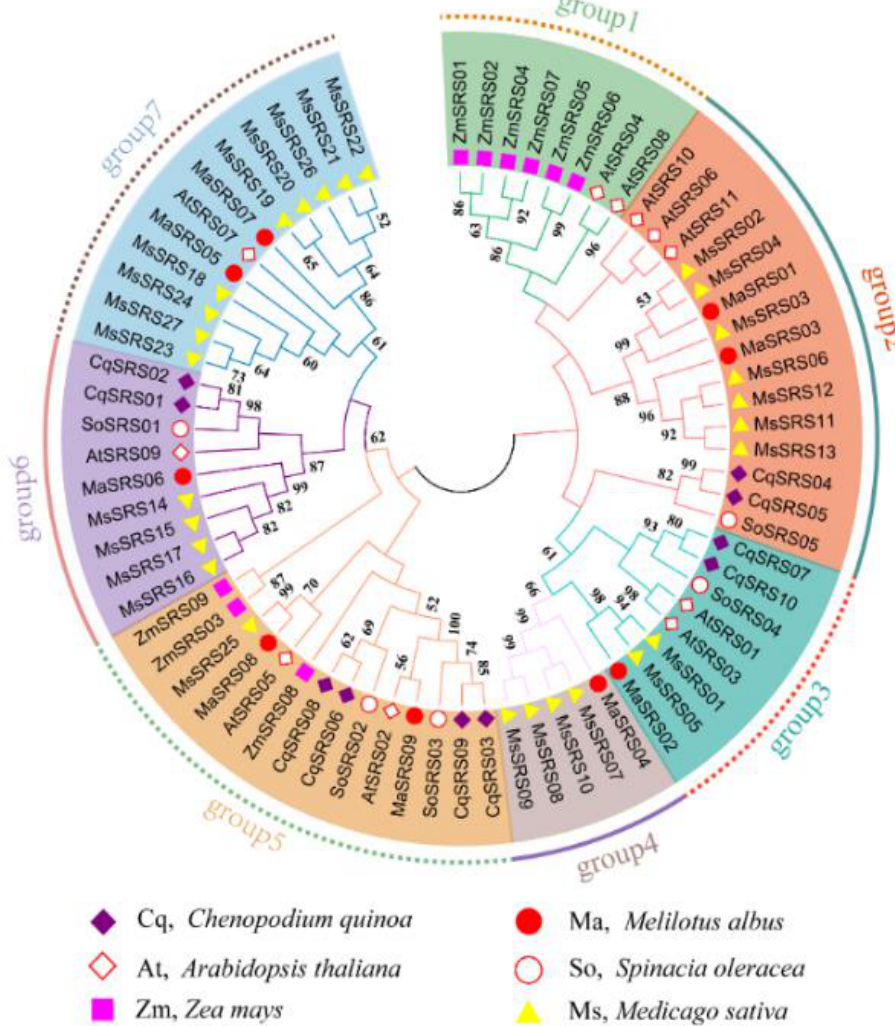
Figure 3. Phylogenetic tree comprising SRS genes from quinoa ( Chenopodium quinoa ) , Arabidopsis ( Arabidopsis thaliana ) , maize ( Zea mays ), white sweet clover ( Melilotus albus ) , spinach ( Spinacia oleracea ), and alfalfa ( Medicago sativa ) . Note: the phylogenetic tree was constructed using MEGA 7.0 with the maximum-likelihood method with 1000 bootstrap replicates. The tree was classified into seven subgroups, designated group1 to group7. The CqSRS , AtSRS , ZmSRS , MaSRS , SoSRS , and MsSRS proteins were labeled by purple rhombus, red, white rhombus, pink squares, red circles, red-white circles, and yellow triangles, respectively.